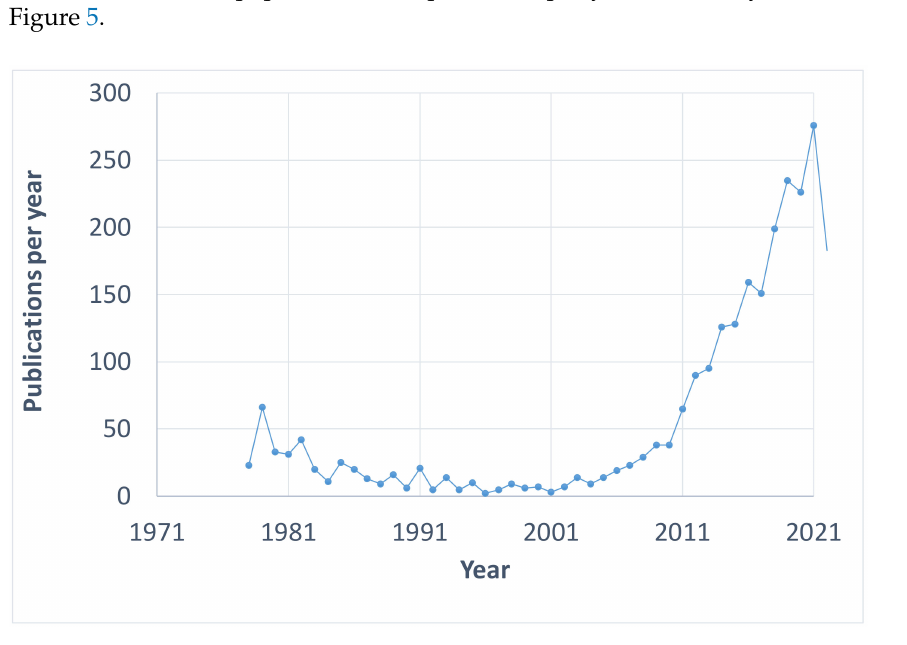
Figure 5. Number of publications per